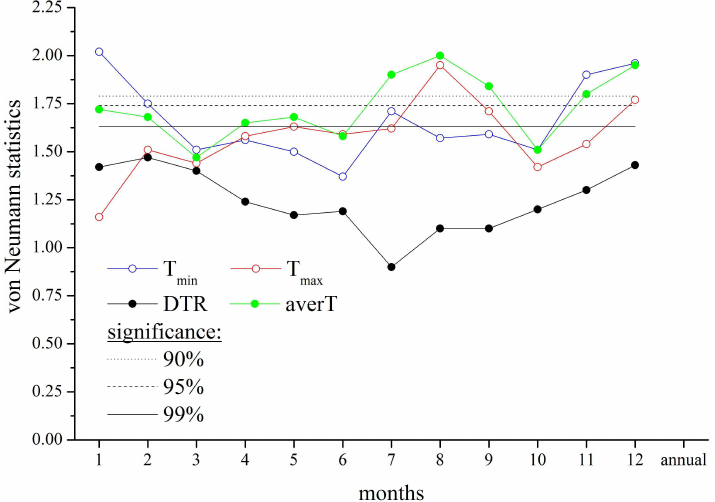
Figure 12. Lisbon: von Neumann ratio statistics for monthly series of T min , T max , DTR and T aver . Black straight lines show probability levels.